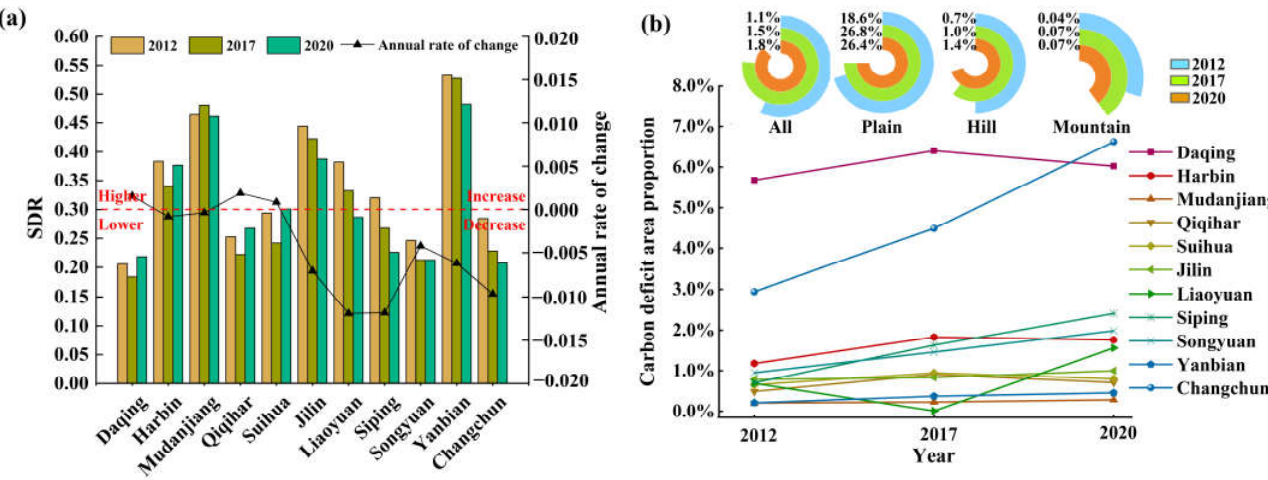
Figure 8. ( a ) The supply–demand ratio and their annual rate of change; ( b ) the temporal variations of the carbon deficit area proportion in each city and landforms from 2012 to 2020.